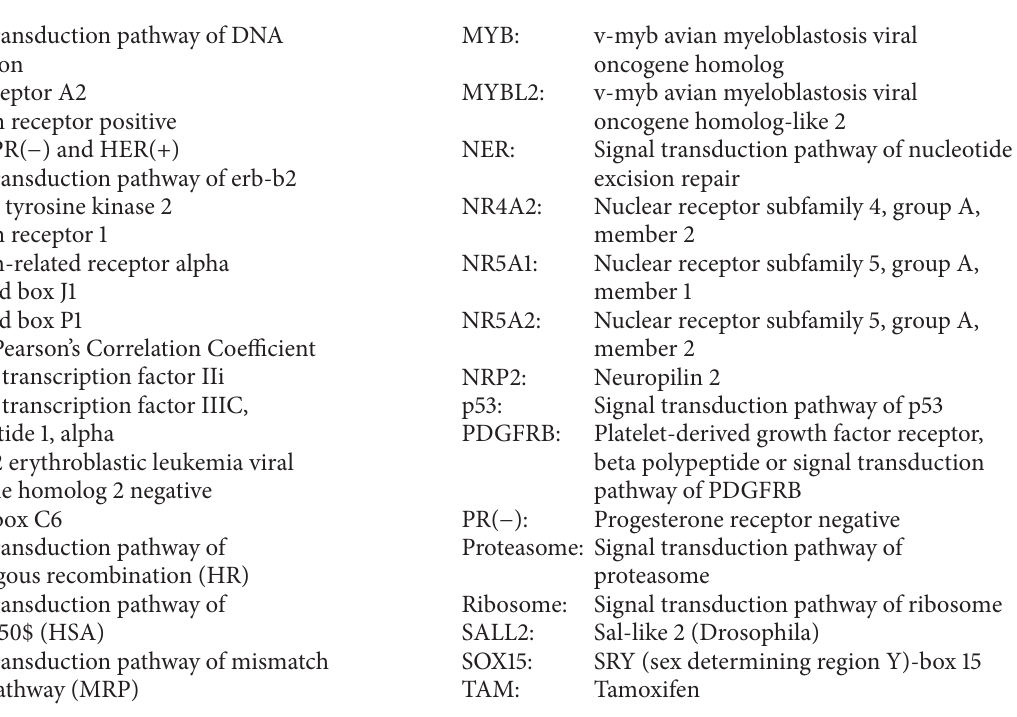
Figure 7: In vivo validation of a favorable prognostic signature in a subset of 181 IDCs. Panel (a) shows the heatmaps of a signature (8 probes) for favorable prognosis to be regulated by NR5A1 and NR5A2 in two subcohorts (subcohort A and subcohort B), respectively. NR5A1 has an opposite regulatory mode as compared to NR5A2 in a subset of 181 IDCs for this inferred subnetwork. Panel (b) shows the survival curves of two subcohorts based on Kaplan-Meier survival